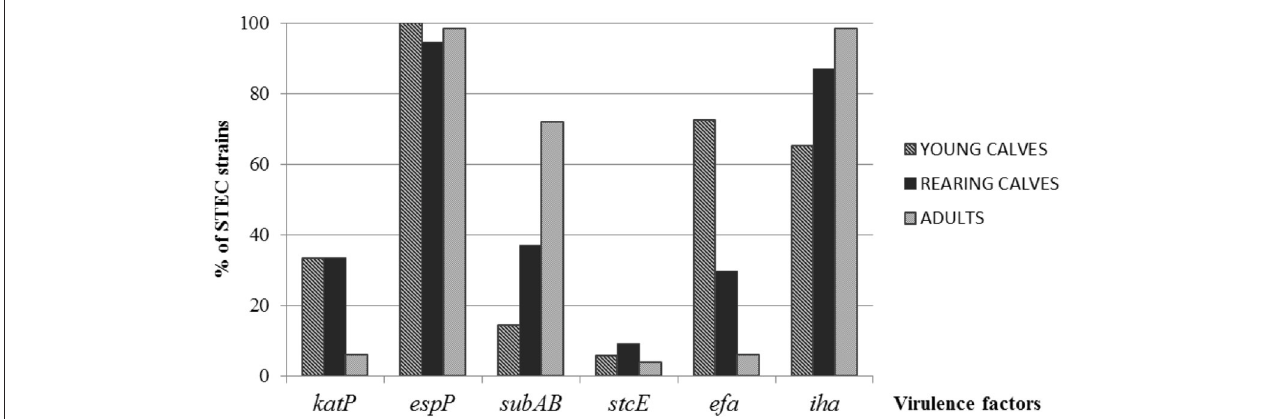
FIGURE 1 | Distribution of virulence factors in STEC strains among the different categories of cattle.